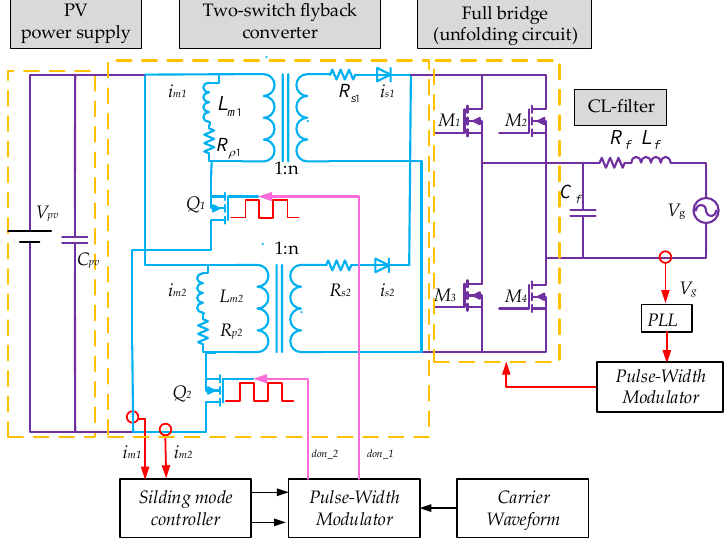
Figure 5. The SMC control diagram of interleaved flyback micro-inverter in DCM.